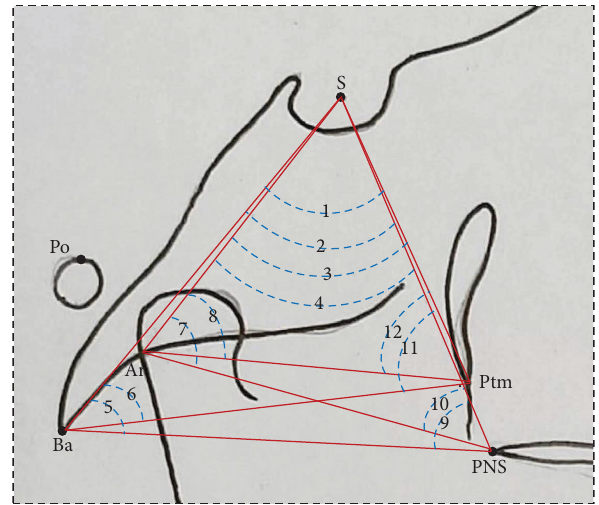
Figure 3: Angular parameters. (1) ∠ Ba-S-Ptm, the angle between Ba, S and Ptm; (2) ∠ Ba-S-PNS, the angle between Ba, S and PNS; (3) ∠ Ar-S-Ptm, the angle between Ar, S and Ptm; (4) ∠ Ar-S-PNS, the angle between Ar, S and PNS; (5) ∠ S-Ba-PNS, the angle between S, Ba, and PNS; (6) ∠ S-Ba-Ptm, the angle between S, Ba, and Ptm; (7) ∠ S-Ar-PNS, the angle between S, Ar and PNS; (8) ∠ S-Ar-Ptm, the angle between S, Ar and Ptm; (9) ∠ S-PNS-Ba, the angle between S, PNS and Ba; (10) ∠ S-PNS-Ar, the angle between S, PNS and Ar; (11) ∠ S-Ptm-Ba, the angle between S, Ptm and Ba; (12) ∠ S-Ptm-Ar, the angle between S, Ptm and